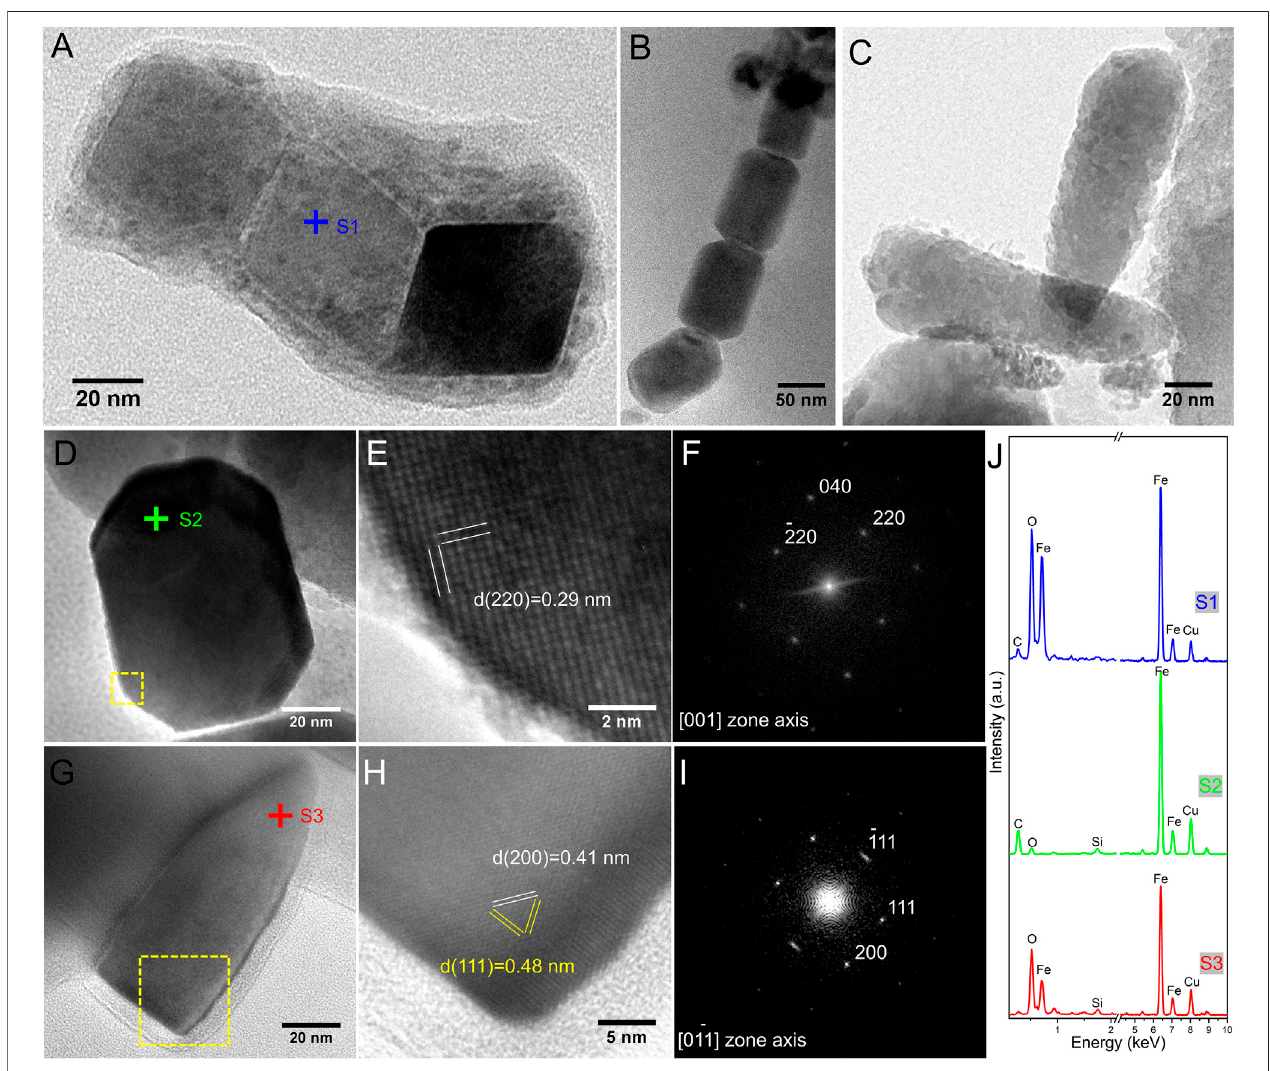
FIGURE 8 | TEM analyses of Type-6 magnetite magnetofossils. (A) Three octahedral magnetite particles with chain structure. (B) Four elongated prismatic magnetite particles with chain structure. (C) Two bullet-shaped magnetite particles. (D) HRTEM image of an individual elongated prismatic particle recorded from the [001] zone axis. (E) Close-up image of the lower left-hand part of the particle in (D) (indicated by the yellow dashed box). (F) FFT pattern from the HRTEM image of the particle in (E) . (G) HRTEM image of a bullet-shaped magnetite particle recorded from the [011] zone axis (H) Close-up image of the lower right-hand part of the particle in (G) (indicated by the yellow dashed box) (I) FFT pattern from the HRTEM image of the particle in (H) . (J) EDXS spectra for different individual particles (for positions of colored crosses in (A) , (D) and (G) ). The d -spacing values from HRTEM observations and indirectly calculated from SAED analyses, combined with corresponding TEM-EDXS point analyses, SAED and FFT patterns, match the crystal structure ( Fd3m space group) of magnetite.